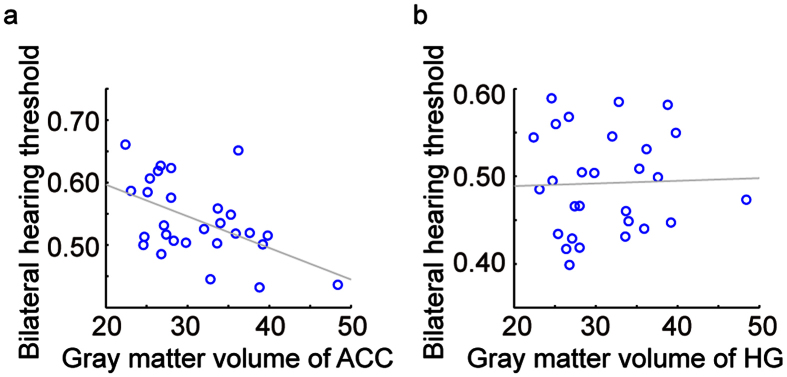
The relationships between the regions of interest (ROIs) and the speech hearing ability.(a) Bilateral hearing threshold of speech in quiet was negatively correlated with the GM volume of the anterior cingulate cortex (r = −0.51, p = 0.005). (b) No significant correlation was found between the GM volume of Heschl’s gyrus and the bilateral hearing threshold of speech in quiet (r = 0.03, p = 0.87). The ROIs were extracted based on the whole-brain analysis of group differences in GM volume between the UHL and NC groups.